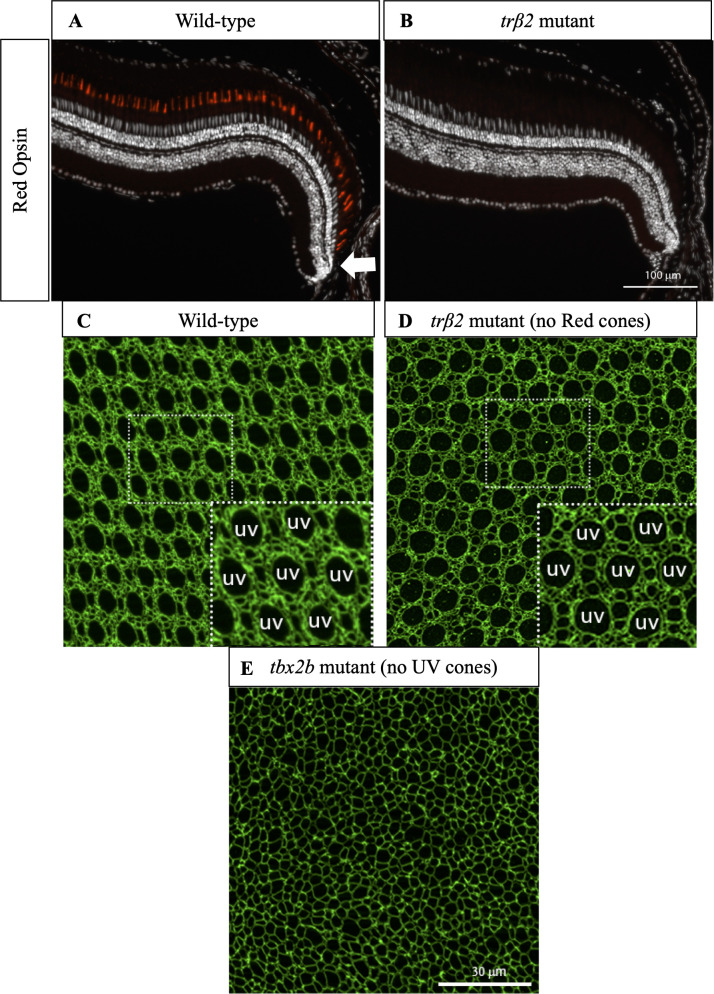
Cone mosaic formation is minimally disrupted in Red cone mutant but is significantly disrupted in UV cone mutant.(A) Cross-section of wild-type retina in which immunostaining of Red cone opsin labels Red cones. White arrow indicates approximate location of precolumn area [40]. (B) Cross-section of trβ2 mutant in which immunostaining of Red cone opsin labels Red cones. Note absence of differentiated Red cones. White arrow indicates approximate location of precolumn area. (C) Apical plane of wild-type cone mosaic lattice in retinal flat-mount in which anti-ZO-1 stains cell profiles. UV cones are indicated in the inset. (D) Apical plane of cone mosaic in retinal flat-mount from trβ2 mutant, which lacks Red cones. Anti-ZO-1 stains cell profiles. UV cones (indicated in inset) identified based on large, rounded profiles. The triangular lattice of UV cones is minimally disrupted in absence of Red cones. (E) Apical plane of cones in retinal flat-mount from tbx2b mutant, which lacks UV cones. The cone mosaic is disrupted in this mutant.